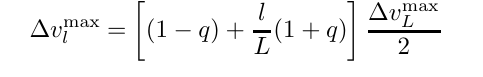
plots for any other location 0 (cid:1) s (cid:1) 1 on the bar. The